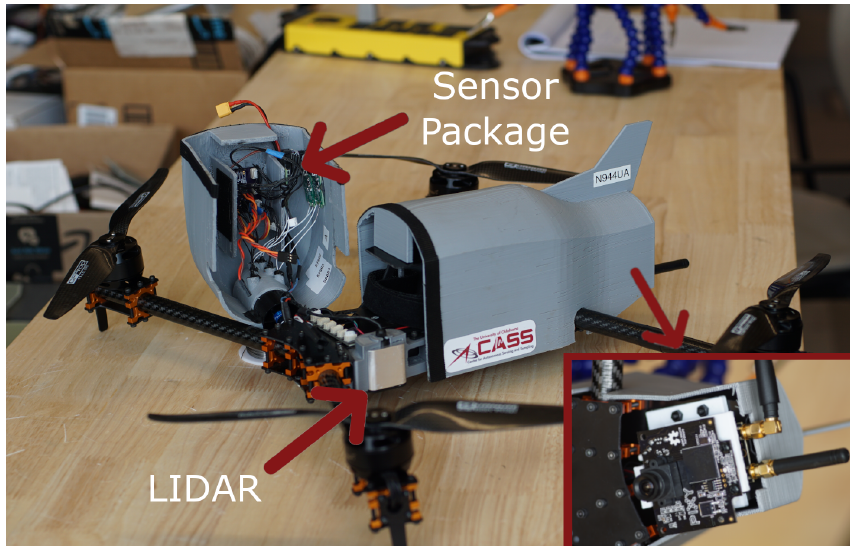
Figure 2. Left side view picture of the CopterSonde UAS illustrating the location of the custom mounts for the LightWare 20/C lidar type rangefinder and the IR-LOCK precision landing camera. The inset picture in the lower right corner shows the camera mounted on the bottom of the CopterSonde. The sensor package is also shown unmounted next to the